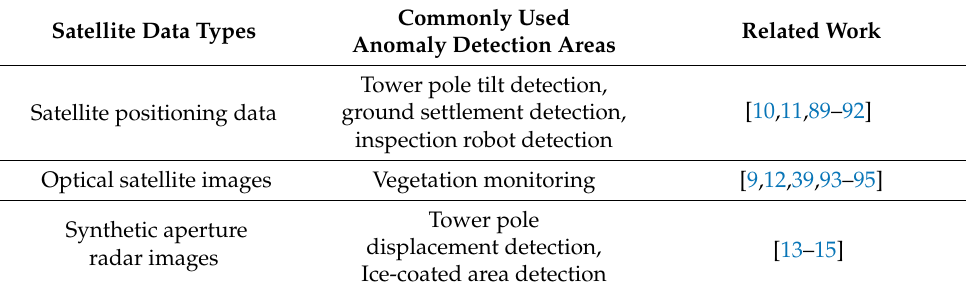
Table 3. Summary of abnormality detection in power grid environment with satellite